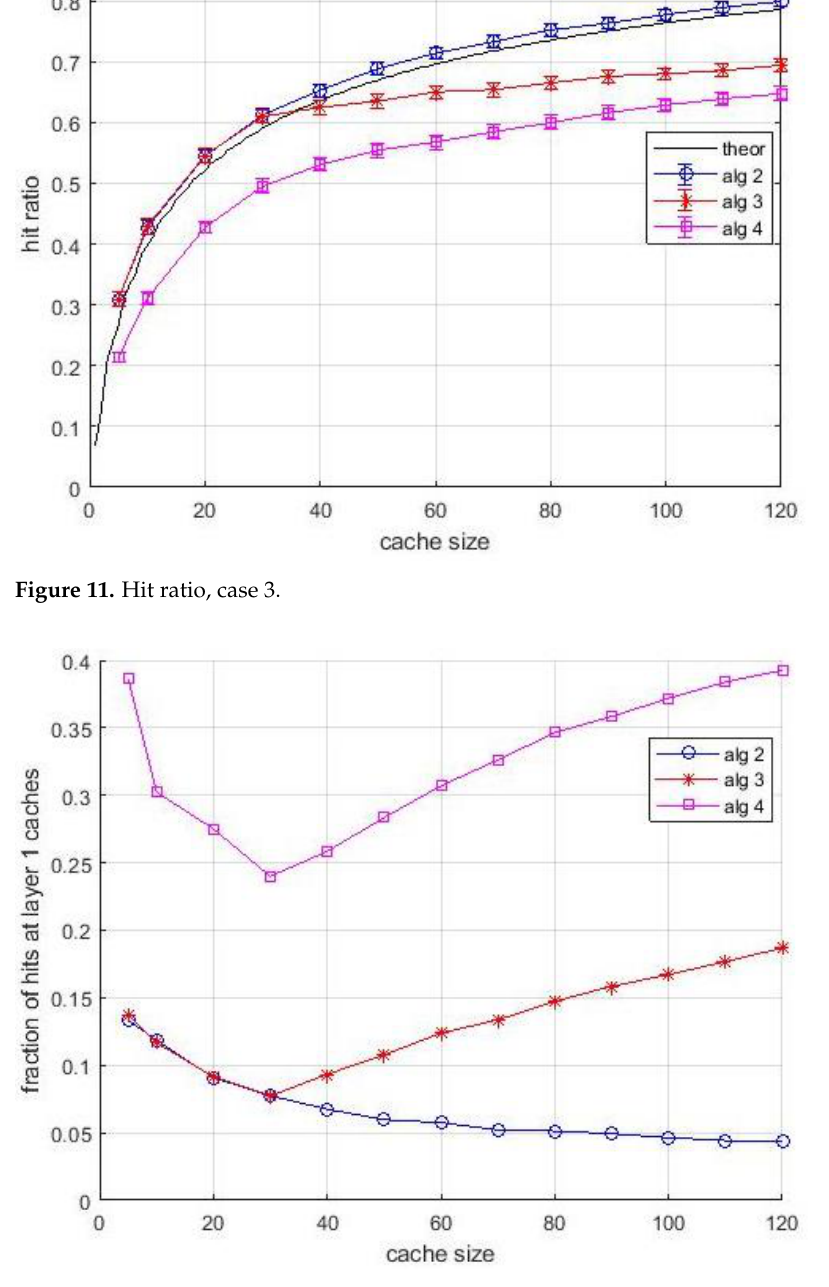
Figure 12. Fraction of hits at 1st layer caches, case